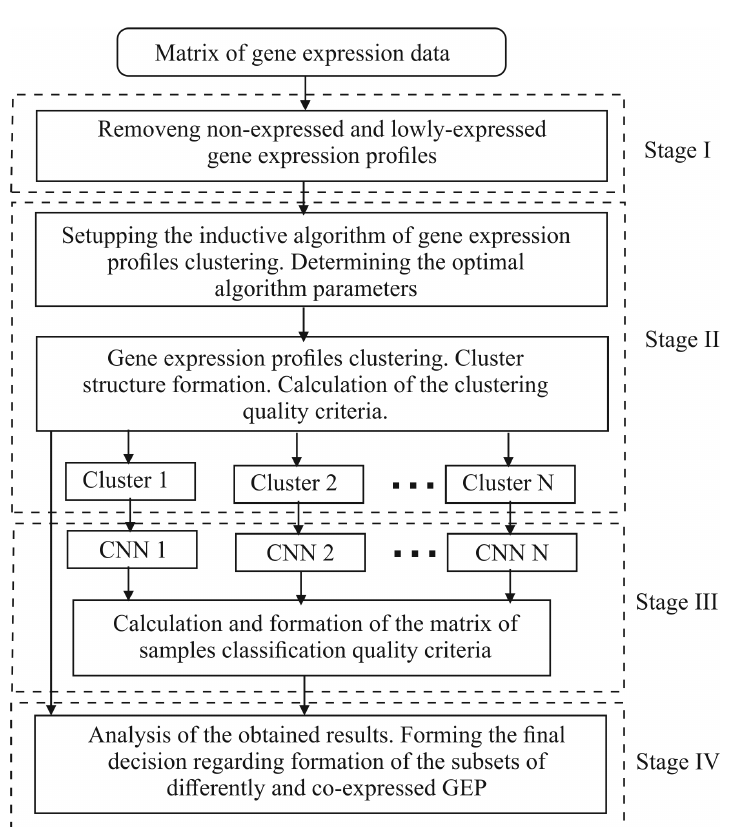
Figure 1. Structural block chart of the stepwise procedure for implementing the concept to form the subsets of differentially expressed and mutually correlated